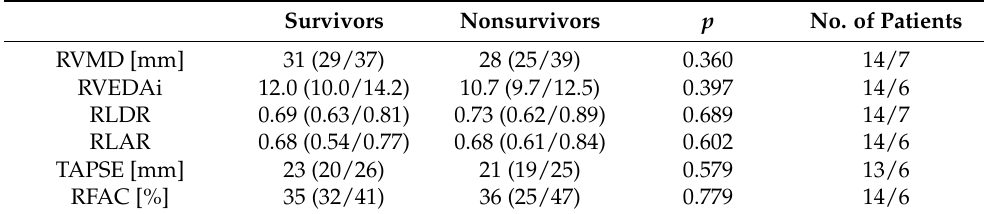
RVMD: right ventricular medial diameter, RVEDAi: RV enddiastolic area index, RLDR: RV/LV diameter ratio, RLAR: RV/LV area ratio, TAPSE: tricuspid annular plain systolic excursion, RFAC: RV fractional area